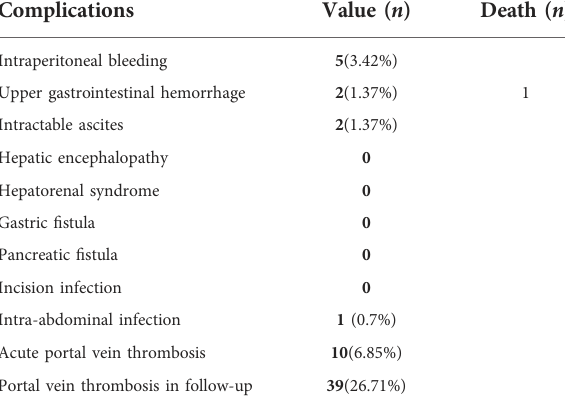
TABLE 3 Complications during hospitalization and PVT in follow-up ( n =146).